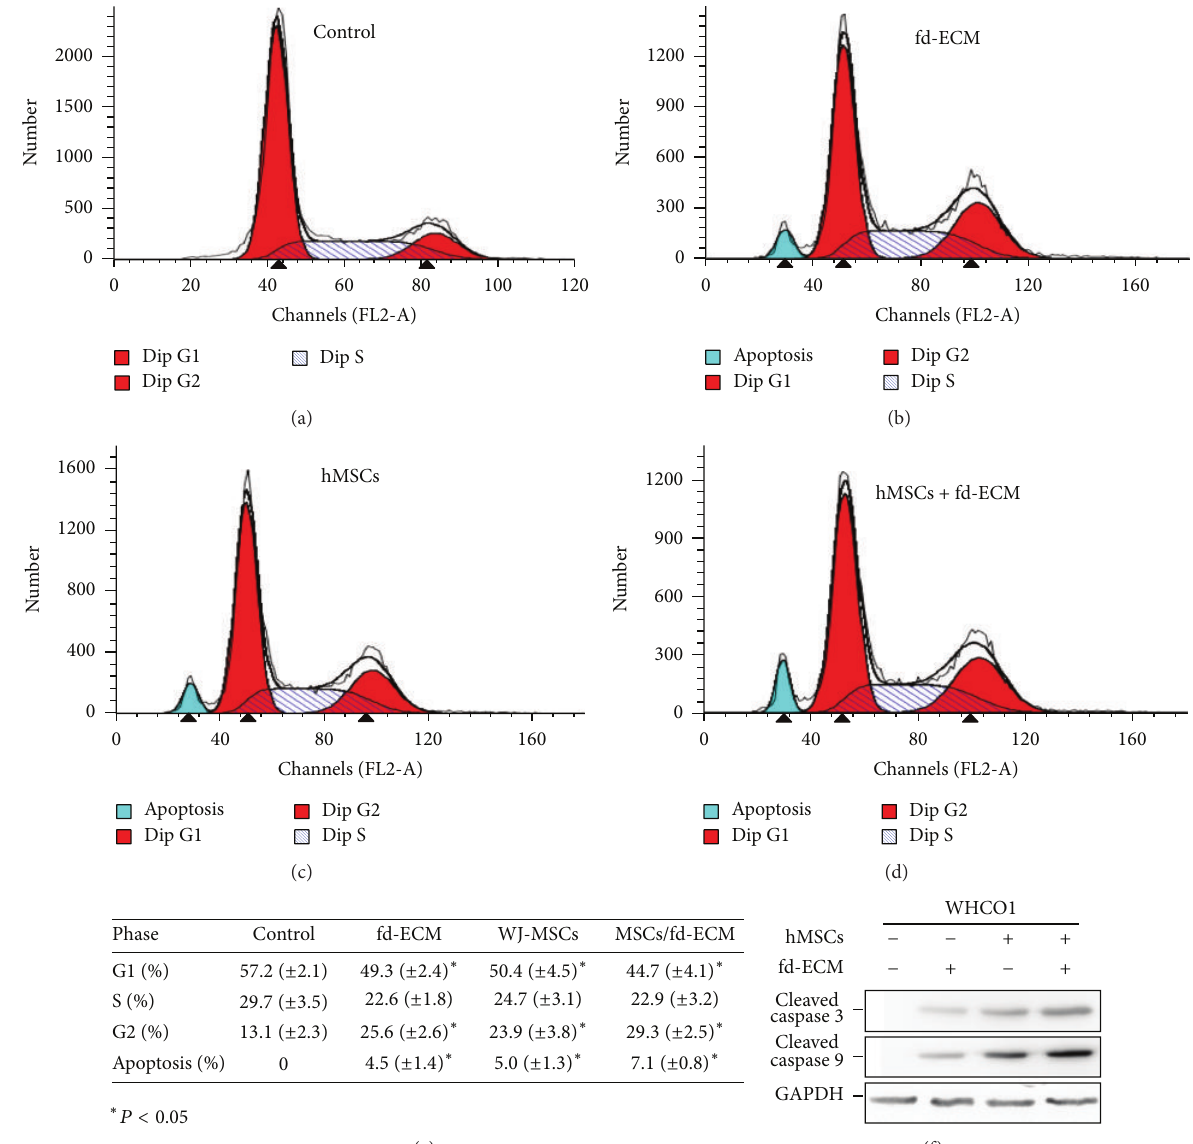
Figure 6: MSCs and fd-ECM synergistically induce cancer cell apoptosis in vitro . (a) Flow cytometric analysis of control WHCO1 cells showed no apparent apoptosis after 48 hrs of incubation. (b) WHCO1 cells were cultured on fd-ECM for 48 hrs and harvested and stained with propidium iodide for cell cycle analysis using flow cytometry. (c) WHCO1 cells were cocultured with MSCs for 48 hrs, harvested, and stained with propidium iodide for cell cycle analysis using flow cytometry. (d) Cocultured WHCO1 cells were plated on an fd-ECM for 48 hrs, harvested, and stained with propidium iodide for cell cycle analysis using flow cytometry. (e) Percentage of cells in each stage of the cell cycle after WHCO1 cells were cultured in MSC-CM, cocultured with MSCs, and cultured on fd-ECM. Four different experiments were pooled together. Data are presented as mean ± standard deviation. ∗ 𝑃 < 0.05 . (f) MSCs and fd-ECM synergistically induce cleaved caspases 3 and 9 expression in WHCO1